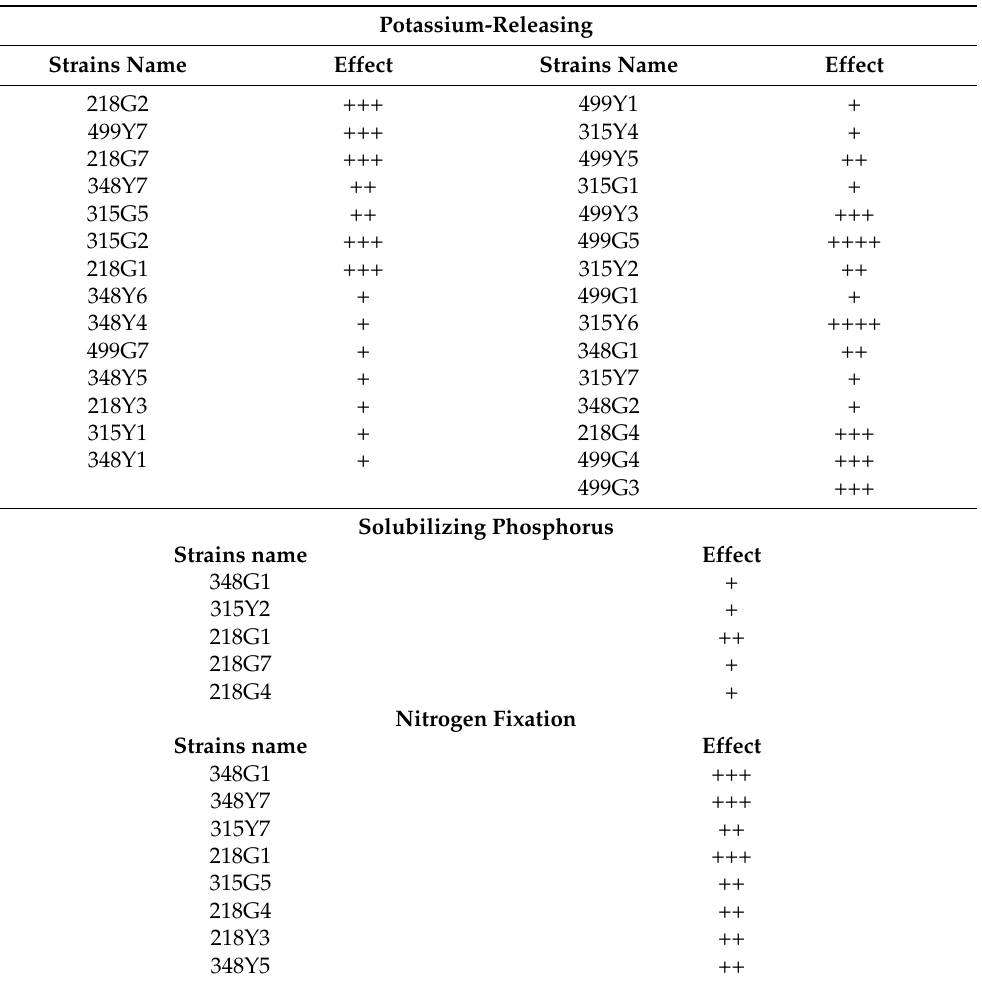
Table 3. Identification of bacterial growth-promoting